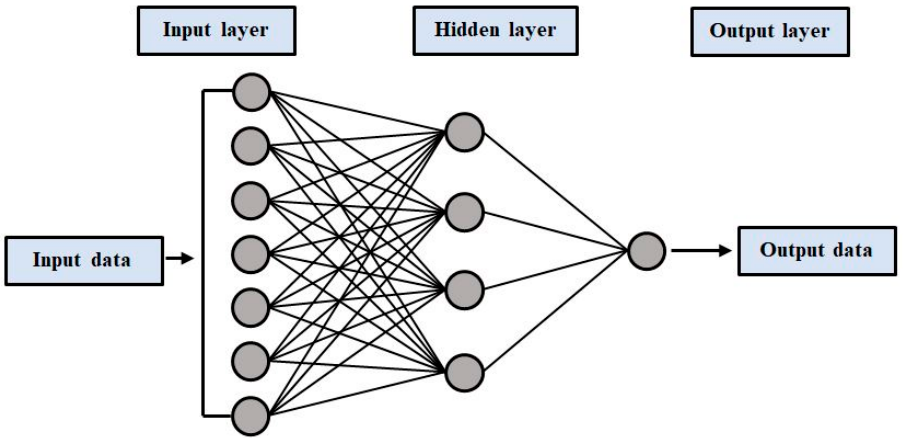
Figure 7. Typical neural network architecture.